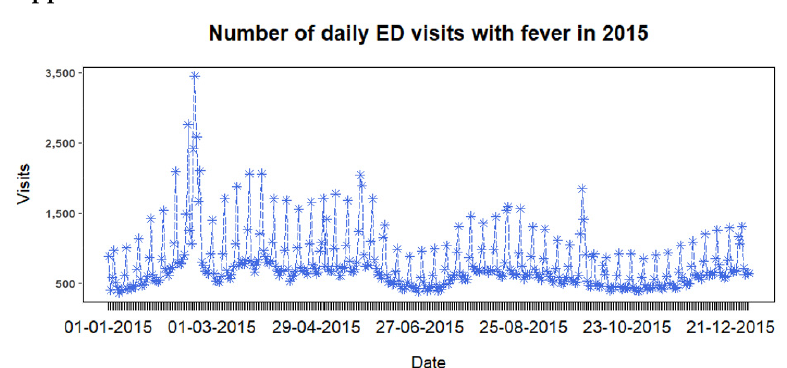
Figure A1. Daily number of ED visits in 2015.